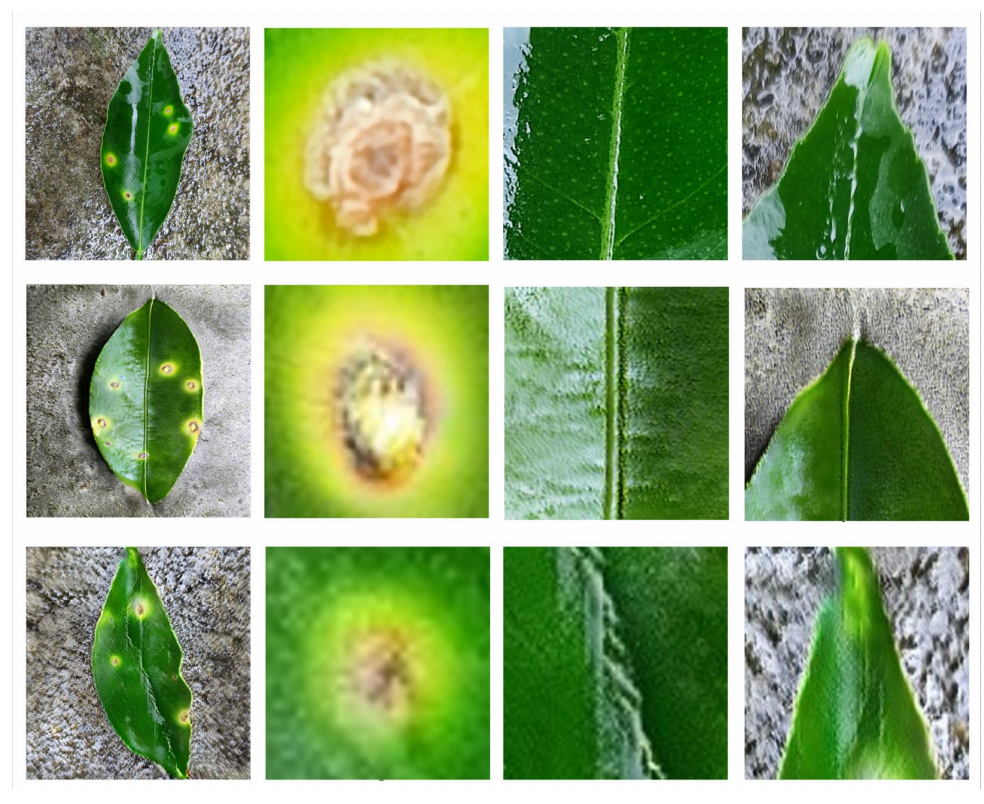
Figure 7. “Real image”, “FastGAN2”, and “FastGAN” images down the sides and “Leaf”, “Lesion”, “Midvein”, and “Leaf tip” images across the